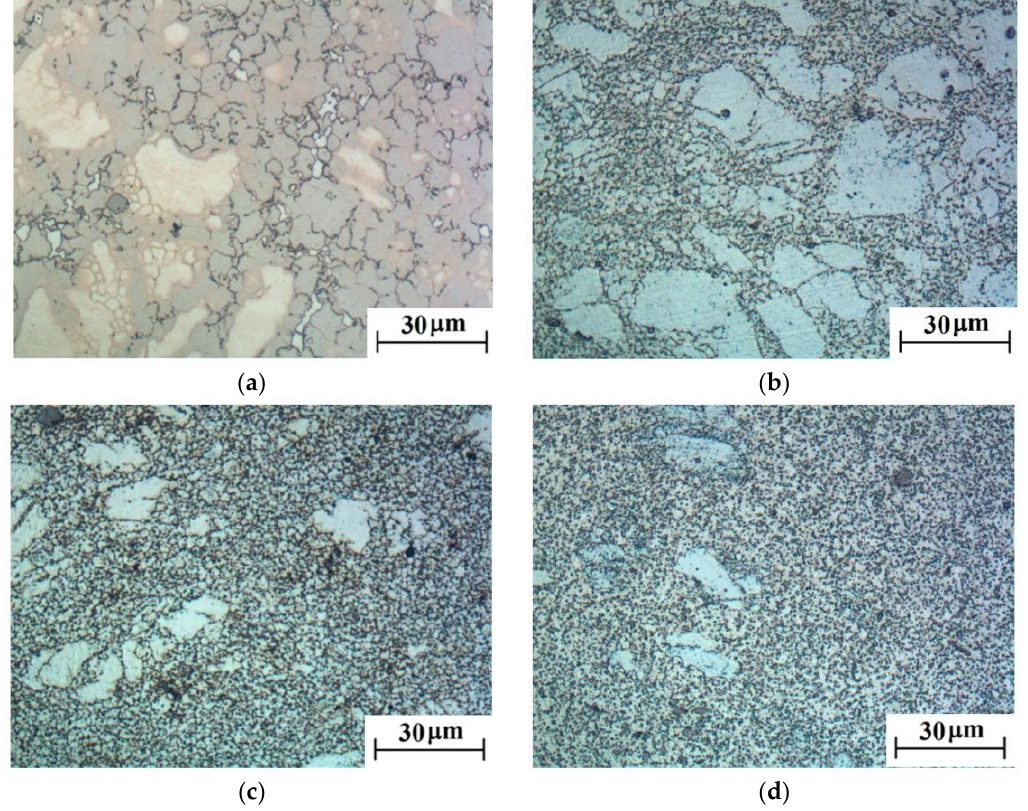
Figure 6. The OM images of the microstructure of AZ61: Initial (hot extruded) state ( a ); after the first TCAP pass ( b ); after the second TCAP pass ( c ); and after the third TCAP pass ( d ).